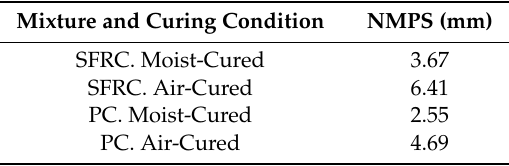
Table 3. Nominal maximum pore size